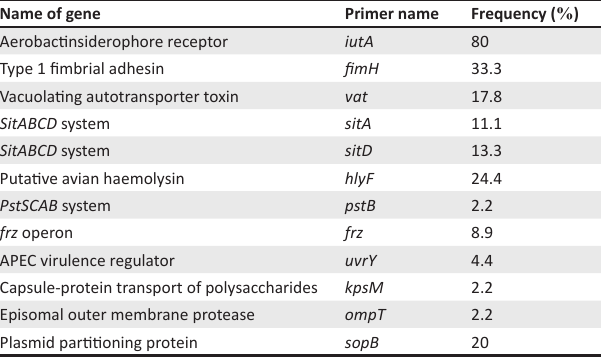
TABLE 2: Frequency of the 12 virulence genes in 45 avian pathogenic Escherichia coli isolates. Name of gene